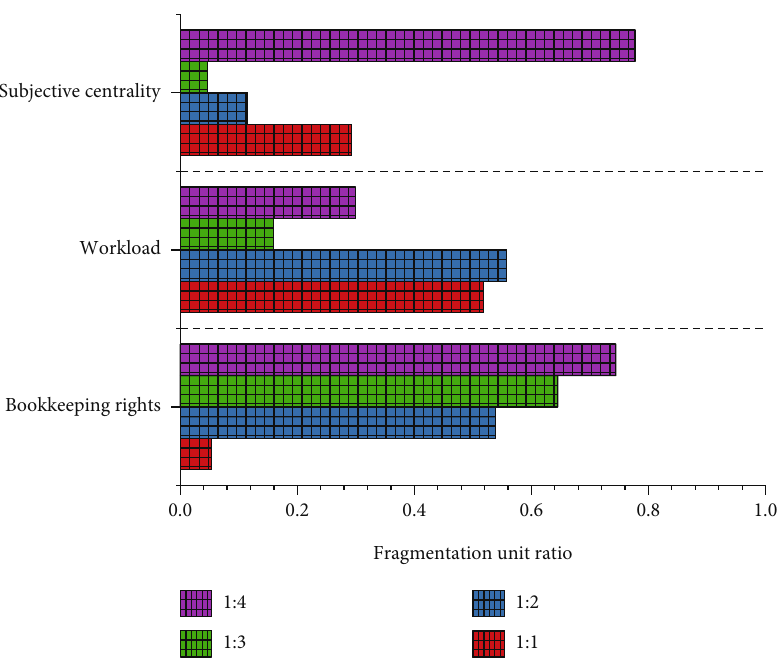
Figure 4: Variation characteristics of pivot parameters for asymmetrically re fi ned meshes.